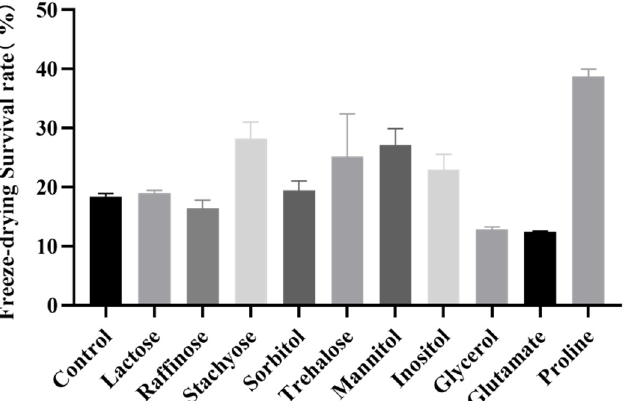
Figure 1. Effects of different substances on the freeze-drying survival rate of B. longum CCFM 1029.